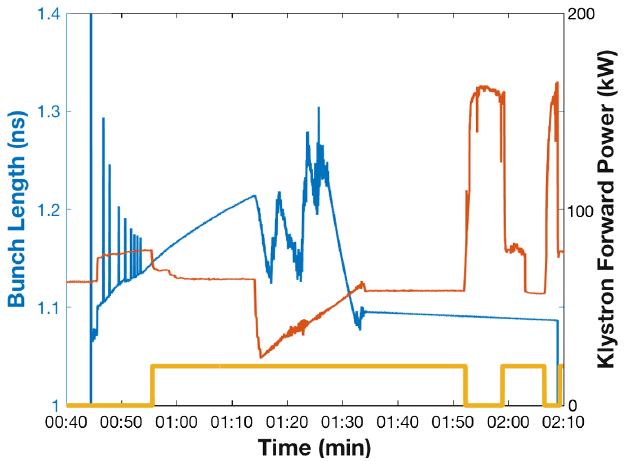
FIG. 17. Phase modulation for all cavities. 1164 bunches, beam